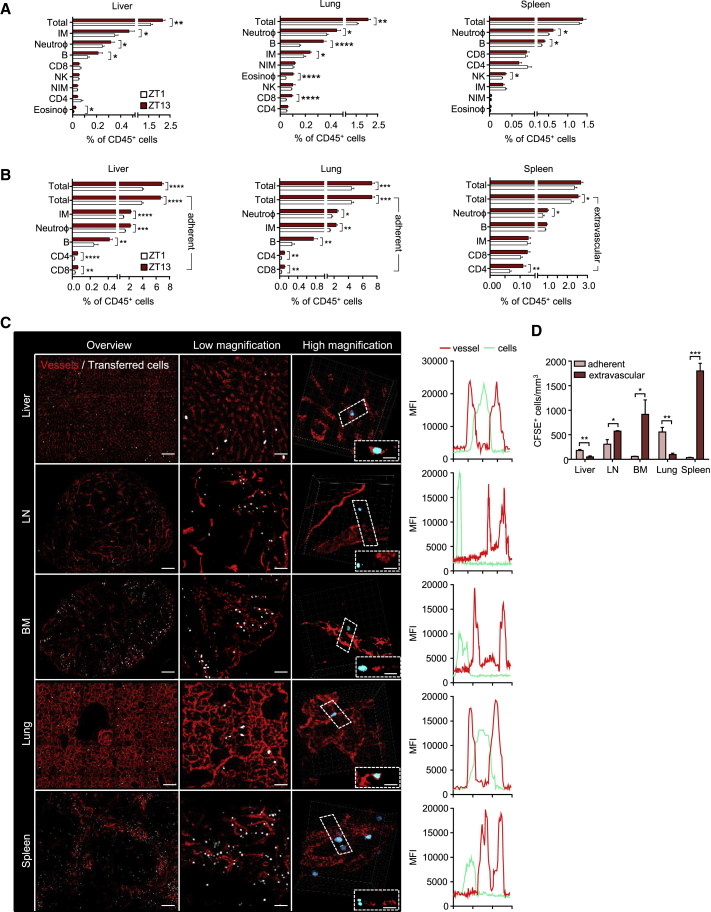
Diurnal Homing Capacity of Leukocyte Subsets to Specific Organs(A) Recruitment of 106 adoptively transferred leukocyte subsets into liver, lung, and spleen at ZT1 and ZT13 (liver, n = 10 mice; lung, n = 10 mice; spleen, n = 24–25 mice; unpaired Student’s t test).(B) Recruitment and localization (extravascular or adherent) of 2 × 106 adoptively transferred leukocyte subsets into liver, lung, and spleen at ZT1 and ZT13 (n = 6–12 mice; unpaired Student’s t test).(C) Whole-mount imaging of organs defines the location of donor cells in adoptive-transfer experiments after perfusion. Boxes indicate exemplary cells whose localization within tissues is additionally shown in the z direction. Line graphs of mean fluorescence intensities (MFI) show their localization inside or outside the vasculature. Scale bars: 150 μm (overviews for liver, bone marrow [BM], lung, and spleen], 200 μm (for lymph node [LN]), 50 μm (low magnification), and 10 μm (high magnification).(D) Quantification of numbers and localization of total transferred cells is based on whole-mount imaging of organs (n = 3 mice; unpaired Student’s t test).∗p < 0.05, ∗∗p < 0.01, ∗∗∗p < 0.001, ∗∗∗∗p < 0.0001. All data are represented as mean ± SEM. See also Figure S4.